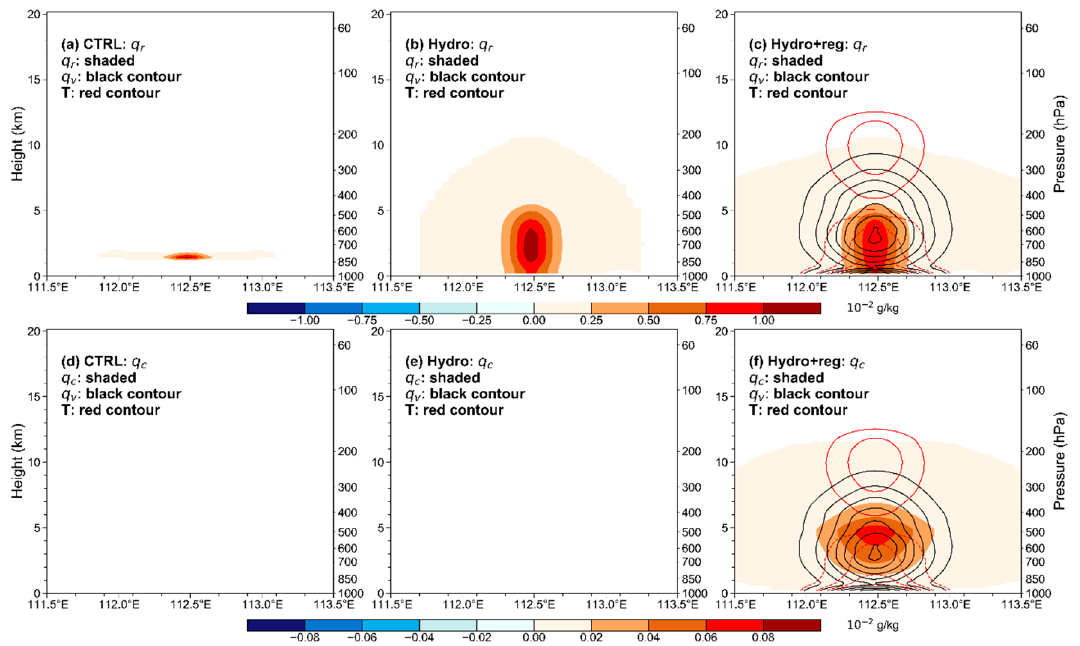
Figure 3. Cross-sections of analysis increment of q r , q c , T and q v by assimilating single radar reflectivity observation at 26.5 ◦ N in CTRL (the left column), Hydro (the center column), and Hydro+reg (the right column) experiments: ( a – c ) q r (shaded, units: 10 − 2 g/kg), T (red contour, units: K) and q v (black contour, units: g/kg); ( d – f ) q c (shaded, units: 10 − 2 g/kg), the T and q v were set in the same way as ( a – c ). The horizontal axis represents the longitude, the left vertical axis is model height (units: km), and the right vertical axis is the pressure level (units: